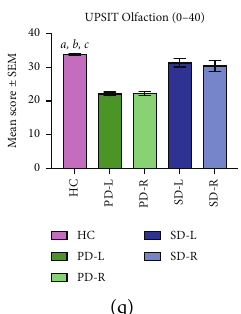
Figure 3: Prevalence of NMS at onset, categorized by laterality of motor symptoms. NMS mean scores were categorized by laterality of motor symptom onset (left (L) or right (R)) for Parkinson’s disease (PD) and SWEDD (SD) along with healthy controls (HC). NMS analyzed are displayed A through Q indicating the score range in the title. Higher number indicates more dysfunction except for MoCA Cognition (J) and USPIT Olfaction (O). Pairwise differences within cohorts (left vs. right) were examined using the nonparametric independent-samples Mann–Whitney U test. Overall differences between cohorts (HC vs. PD vs. SWEDD) were evaluated using the nonparametric independent- samples Kruskal–Wallis test. Post hoc analyses signifying differences between the HC, PD, and SWEDD cohorts are indicated as a � HC versus PD, b � HC versus SWEDD, and c � PD versus SWEDD. p < 0 .